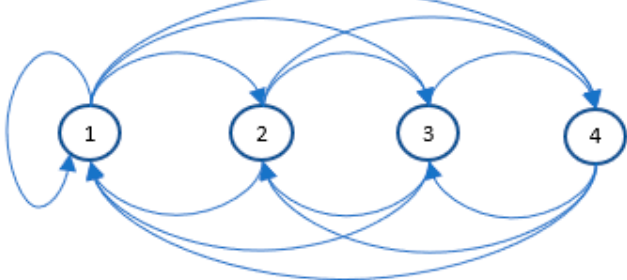
Figure 11. Example—communication model. Table 4. Example 2: Results from four tests for the graph model.